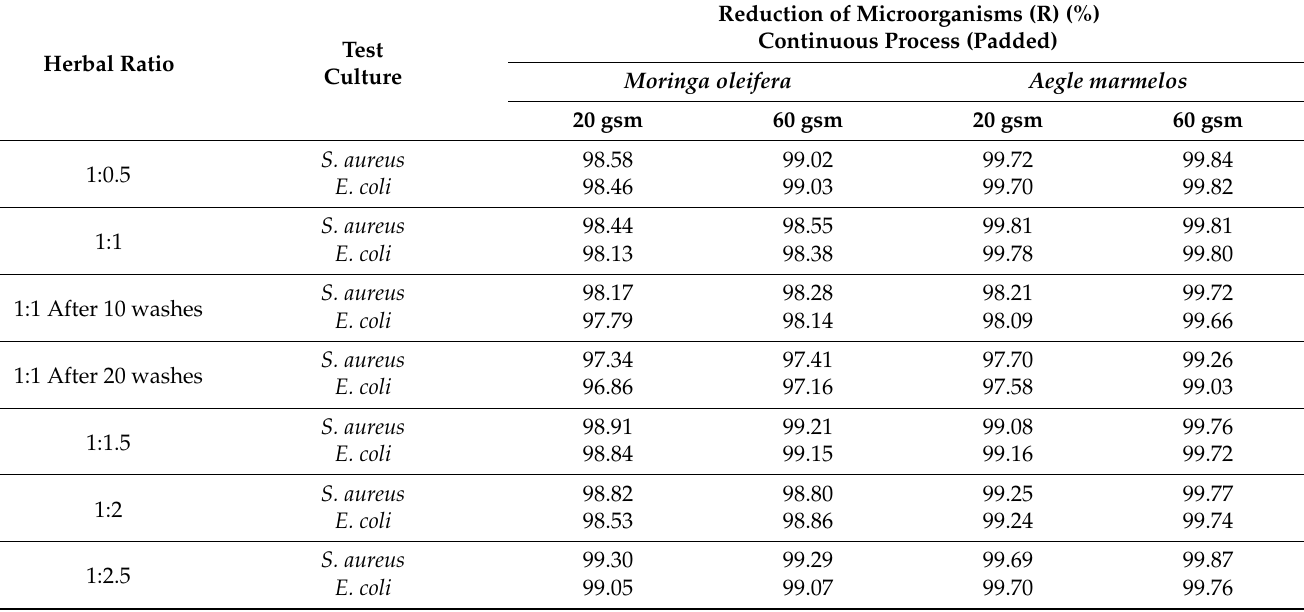
Table 2. Reduction of micro-organisms (AATCC 100)—continuous process (padding method).